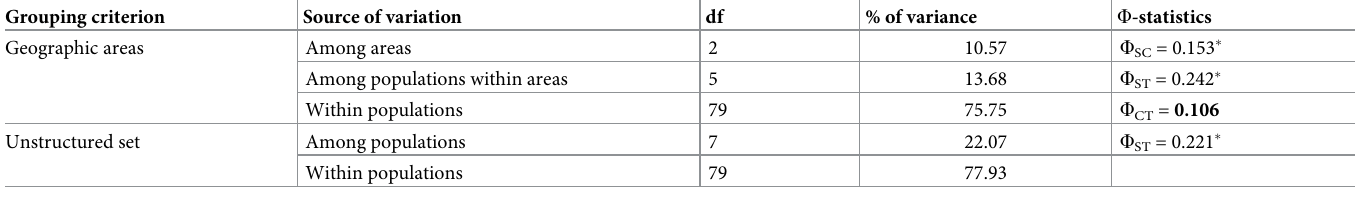
Table 3. Analysis of molecular variance AMOVA for the extended 12S dataset of the mtDNA for D . dentifera . The significances of F -statistics values were tested by a permutation test with 10000 replicates. Grouping criterion